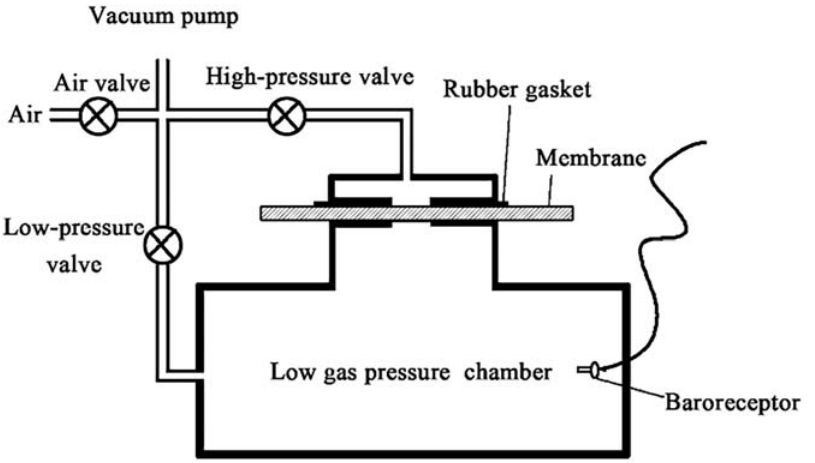
Figure 2: Schematic of the gas permeation test